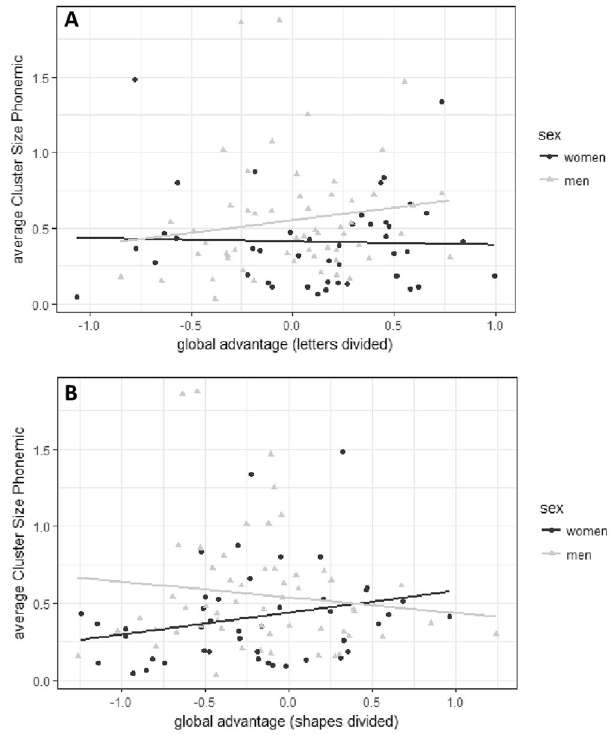
Figure 3. Relationship of the GA effect to clustering in the phonemic fluency task. A larger GA effect in the letters divided condition was related to larger clusters in men ( A ), while the GA effect in the shapes divided condition was related to larger clusters in women ( B